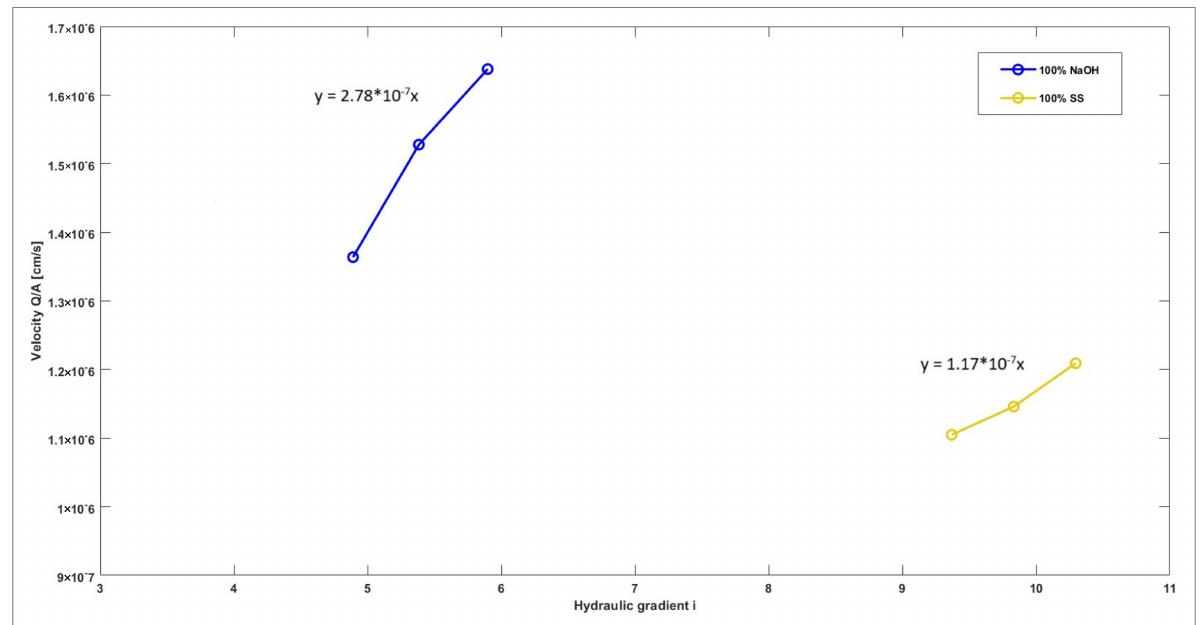
Figure 19. Permeability test results of the created geopolymers.